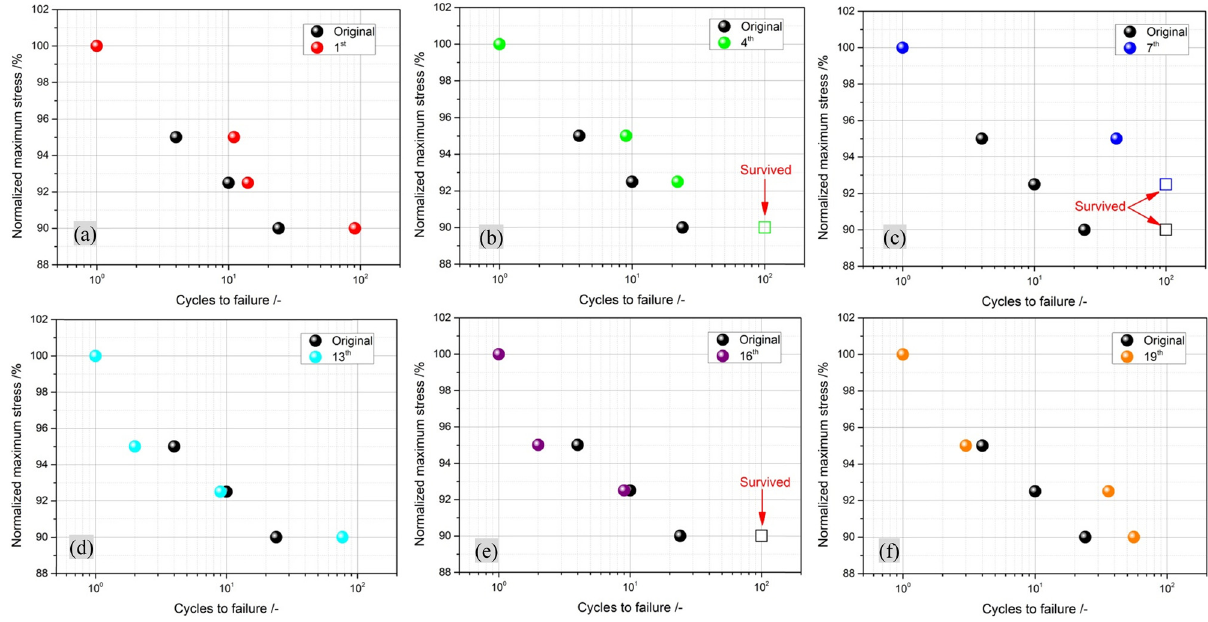
Figure 10: Normalized maximum stress versus cycles to failure of the CF/epoxy laminates with and without fiber breakages in different